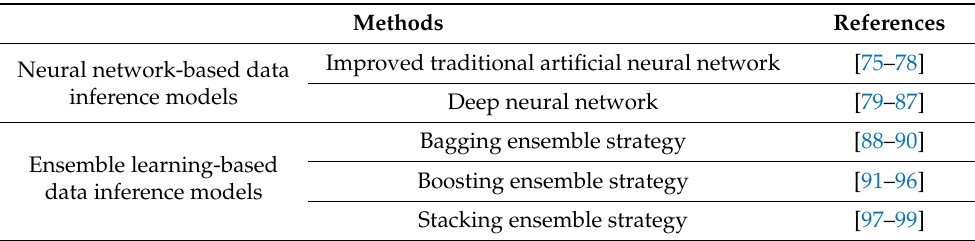
Table 3. Summary of data inference models and references.